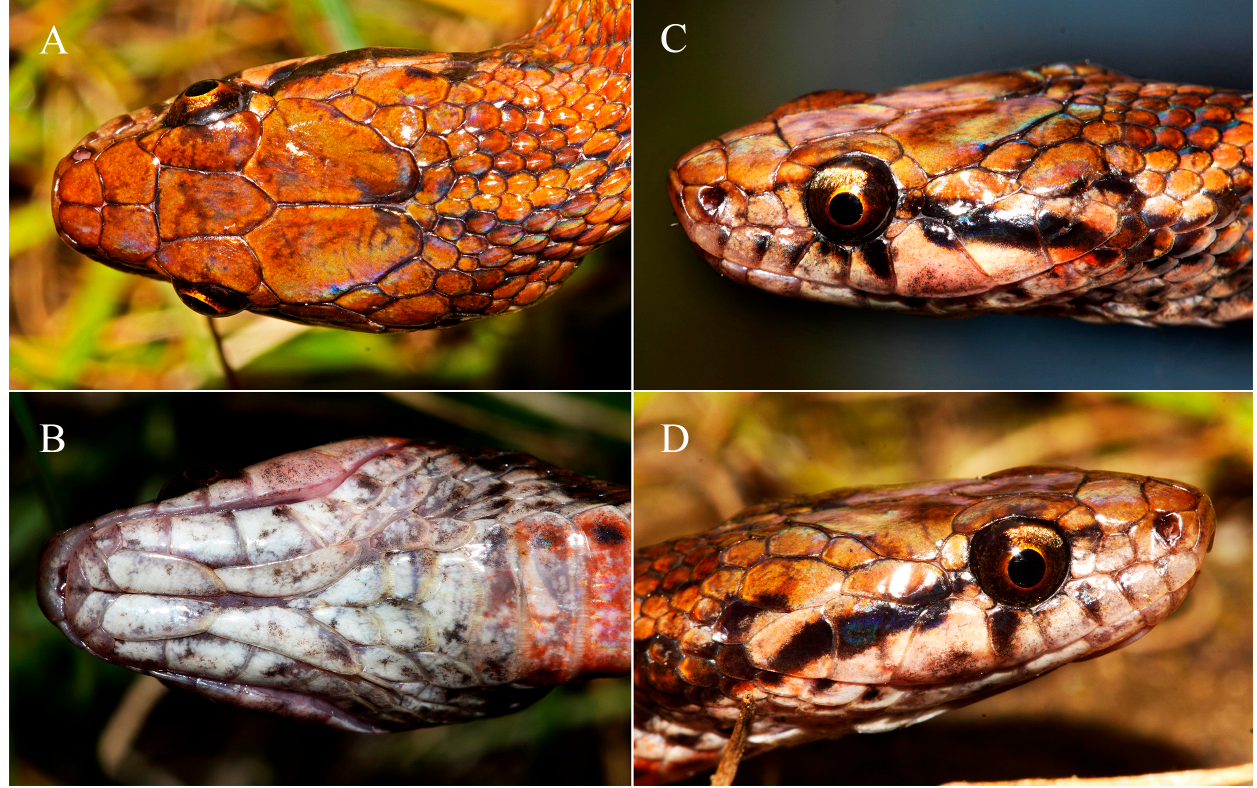
Figure 8. Herpetoreas tpser sp. nov. showing color in life, KIZ 06681, adult female, from 80K, Mêdog County, Xizang Au ‐ tonomous Region, China. ( A ) dorsal head view; ( B ) ventral head view; ( C ) right side of head view; ( D ) left side of head view. Photographs by Mian